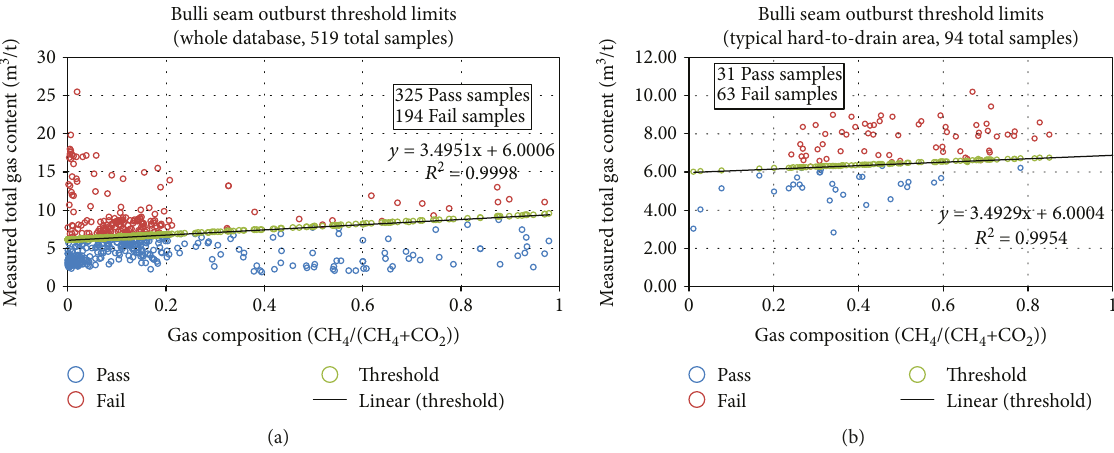
Figure 11: Bulli seam outburst threshold limits. (a) Whole database. (b) Typical hard-to-drain